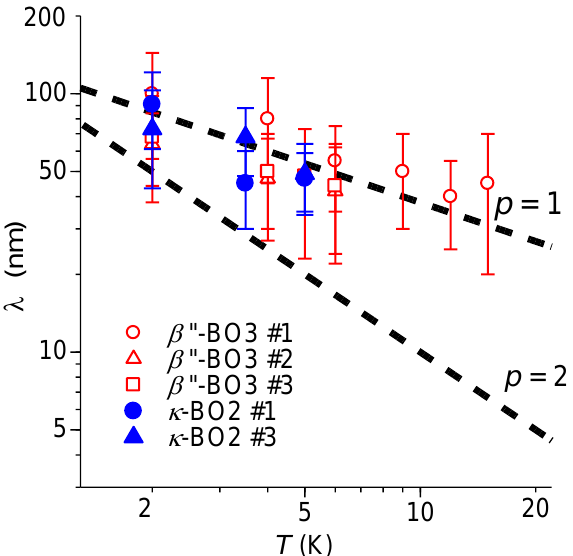
Figure 6. Temperature dependence of the phase coherence length λ for β ” -BO3 (sample #1, #2, #3), κ -BO2 (sample #1, #3). The broken lines represent the temperature dependence following λ ∝ T − p /2 with p = 1 or p = 2.